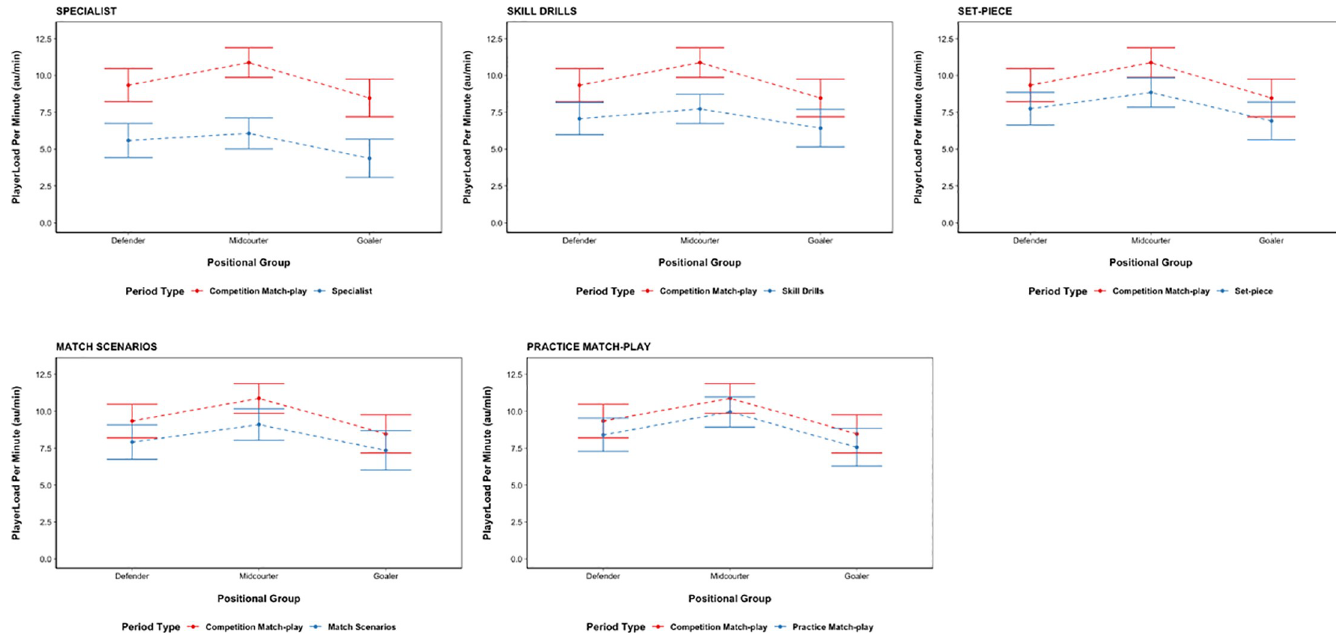
Fig 1. Comparison of PlayerLoad ™ per minute for each activity type against competition Match-play. The model estimated marginal means and 95% confidence intervals are presented for each of the comparisons. Abbreviations; au/min = arbitrary units per